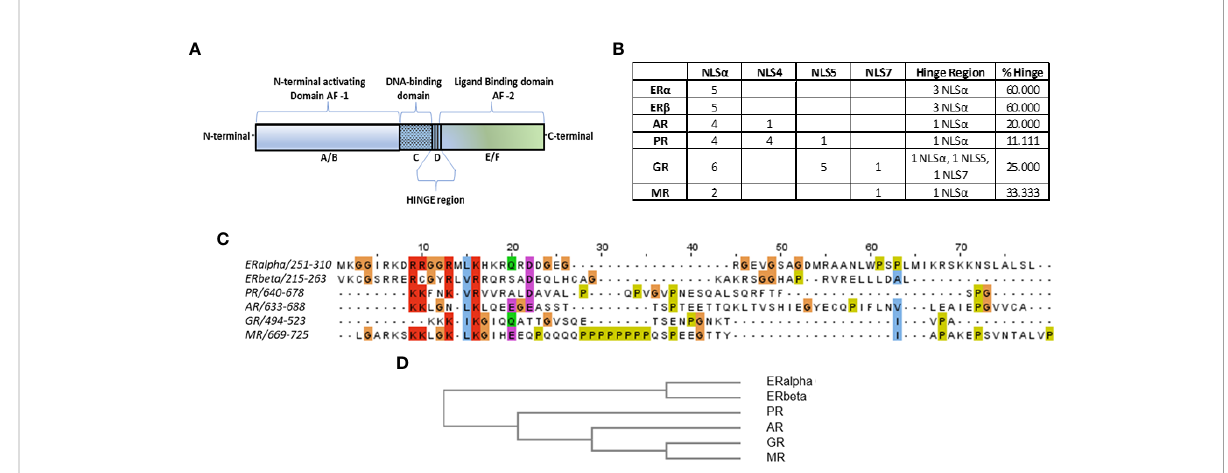
FIGURE 1 (A) Schematic representation of nuclear receptors functional domains. (B) Table summarizes the identi fi ed importins a , 4, 5 and 7 NLS sequences in the structure of steroid hormone receptors (columns 2-5), according to data presented in Supplemental Figure 1. In column 6, the detailed number of putative NLS sequences in the hinge region of each receptor is presented, while in column 7 the percentage of the hinge region-identi fi ed NLS over the total NLS sequences is presented. (C) Alignment of the hinge regions of steroid hormone receptors, with the MafftWS algorithm (11) in JalView V2.11.2.2 (12). Coloring of amino acids is presented according to the CrustalW color scheme (13) (see http:// www.jalview.org/help/html/colourSchemes/clustal.html for details). (D) Similarity tree of the hinge region of steroid hormone receptors with the Blosum62 algorithm, performed in